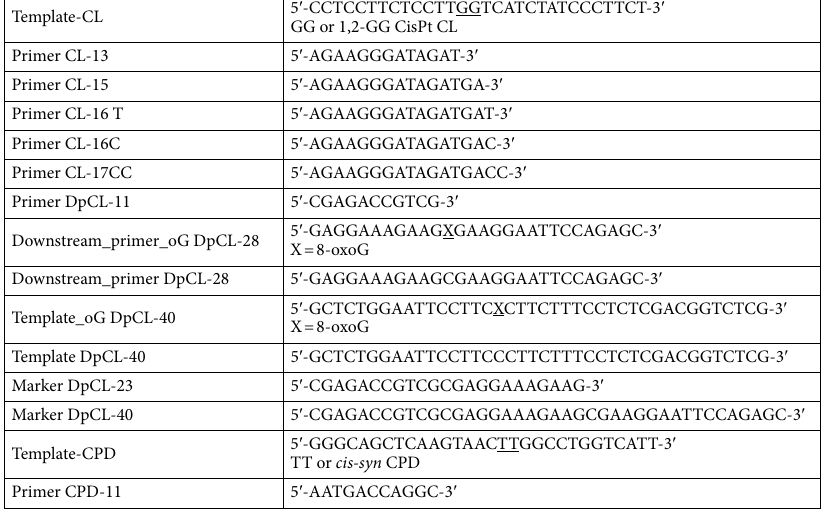
Table 1. Oligonucleotides used in the